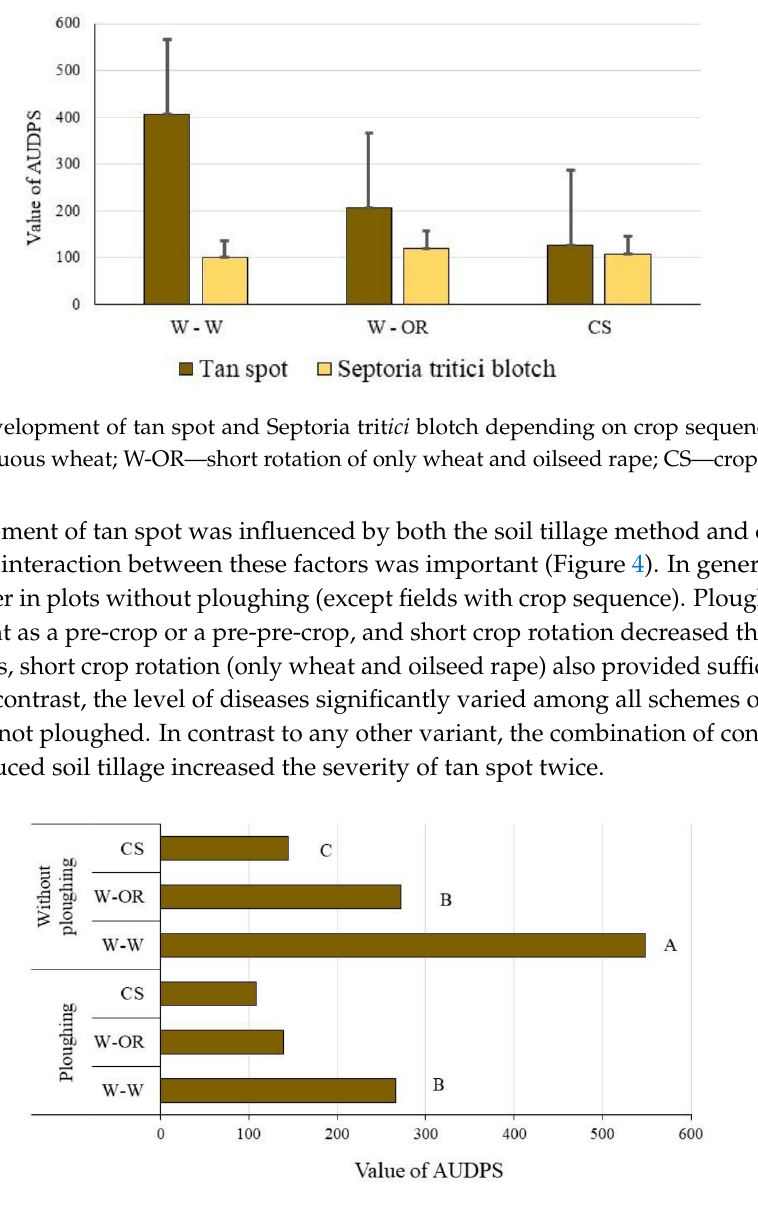
Figure 4. Development of tan spot depending on crop sequence and soil tillage method. Different letters among trials’ means indicate significant differences according to a post hoc multiple comparison LSD